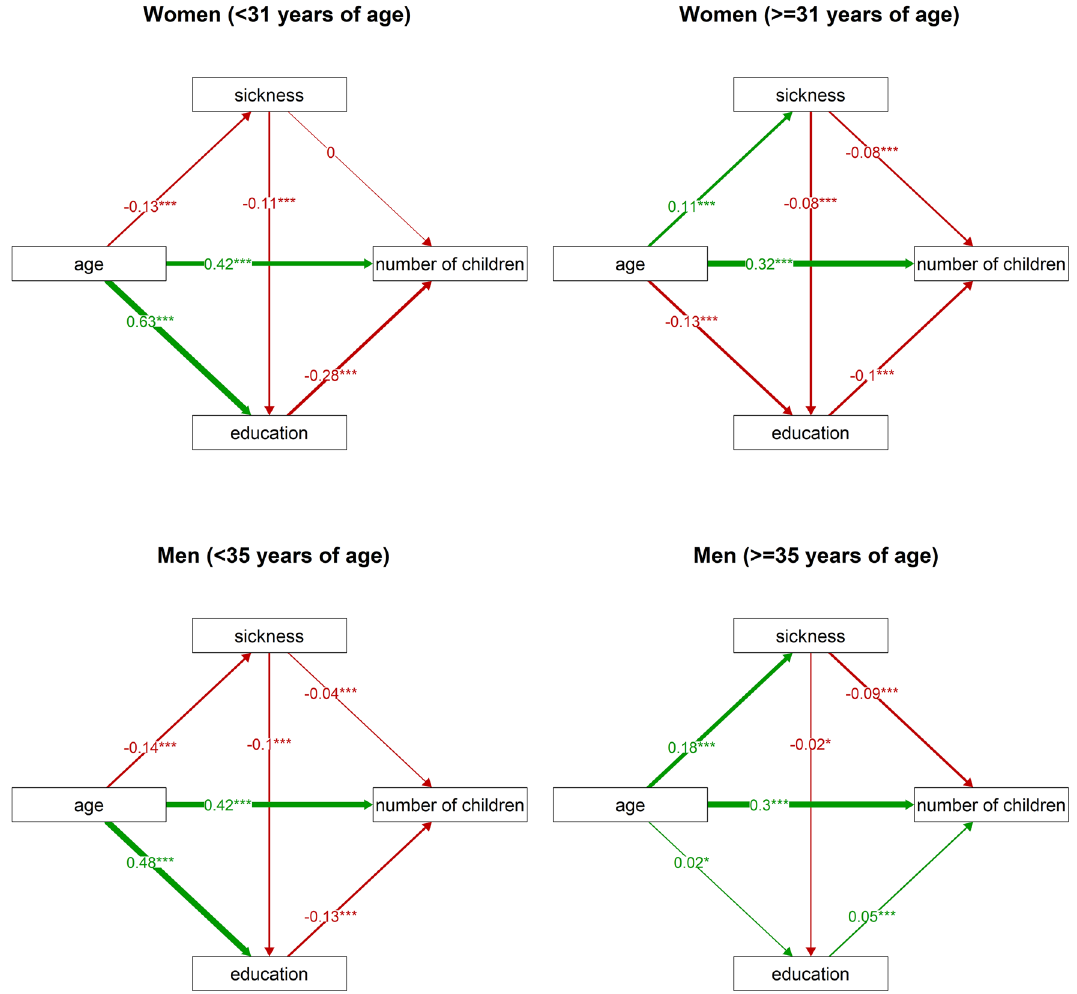
Figure 4. Direct and indirect effects of the sickness index on the number of children in women and men. This figure shows the results of path analyses: it visualises relations between the number of children, the sickness index, education, and age, separately for women under 31 years of age (top left), women over 31 years of age (top right), men under 35 years of age (bottom left), and men over 35 years of age (bottom right). The numbers at arrows show standardised parameter estimates. Associations with p values under 0.05 are marked by ‘*’, those with p values under 0.01 are marked by ‘**’, and those with p values under 0.001 are marked by